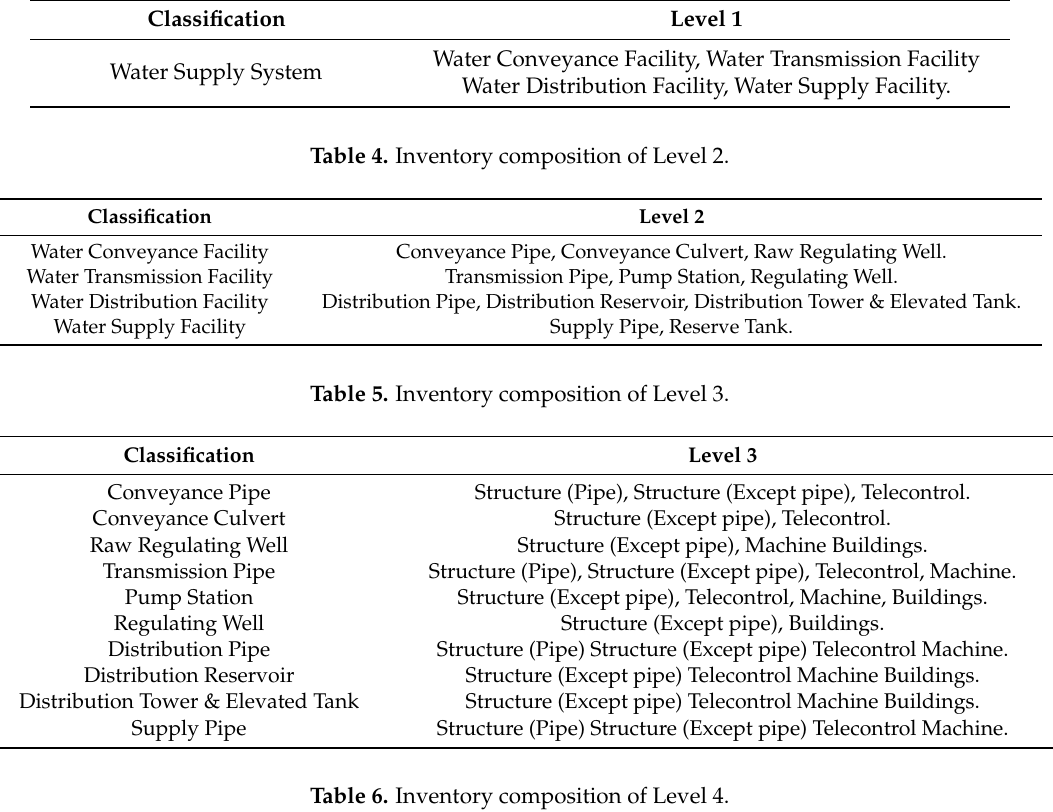
Table 6. Inventory composition of Level